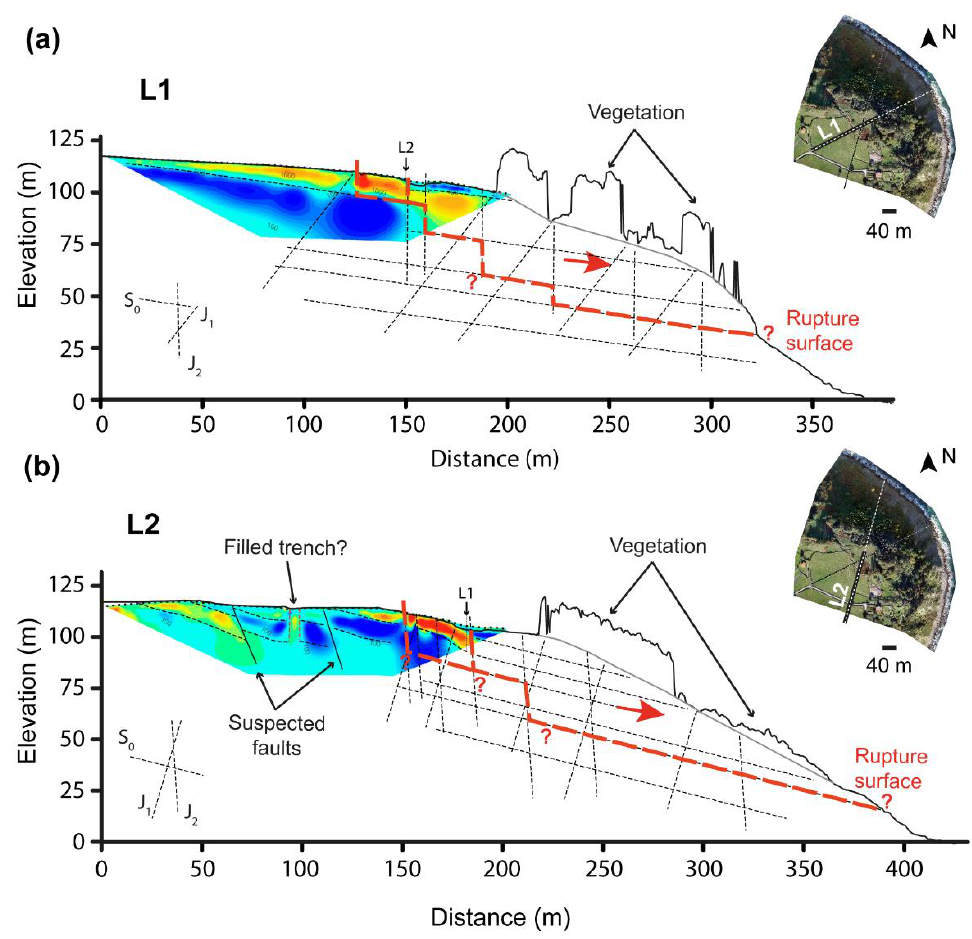
Figure 6. ( a ) In-depth interpretation of the section running along Line 1 of the electrical tomography and reaching the sea. ( b ) In-depth interpretation of the section running along Line 2 of the electrical tomography and reaching the sea.